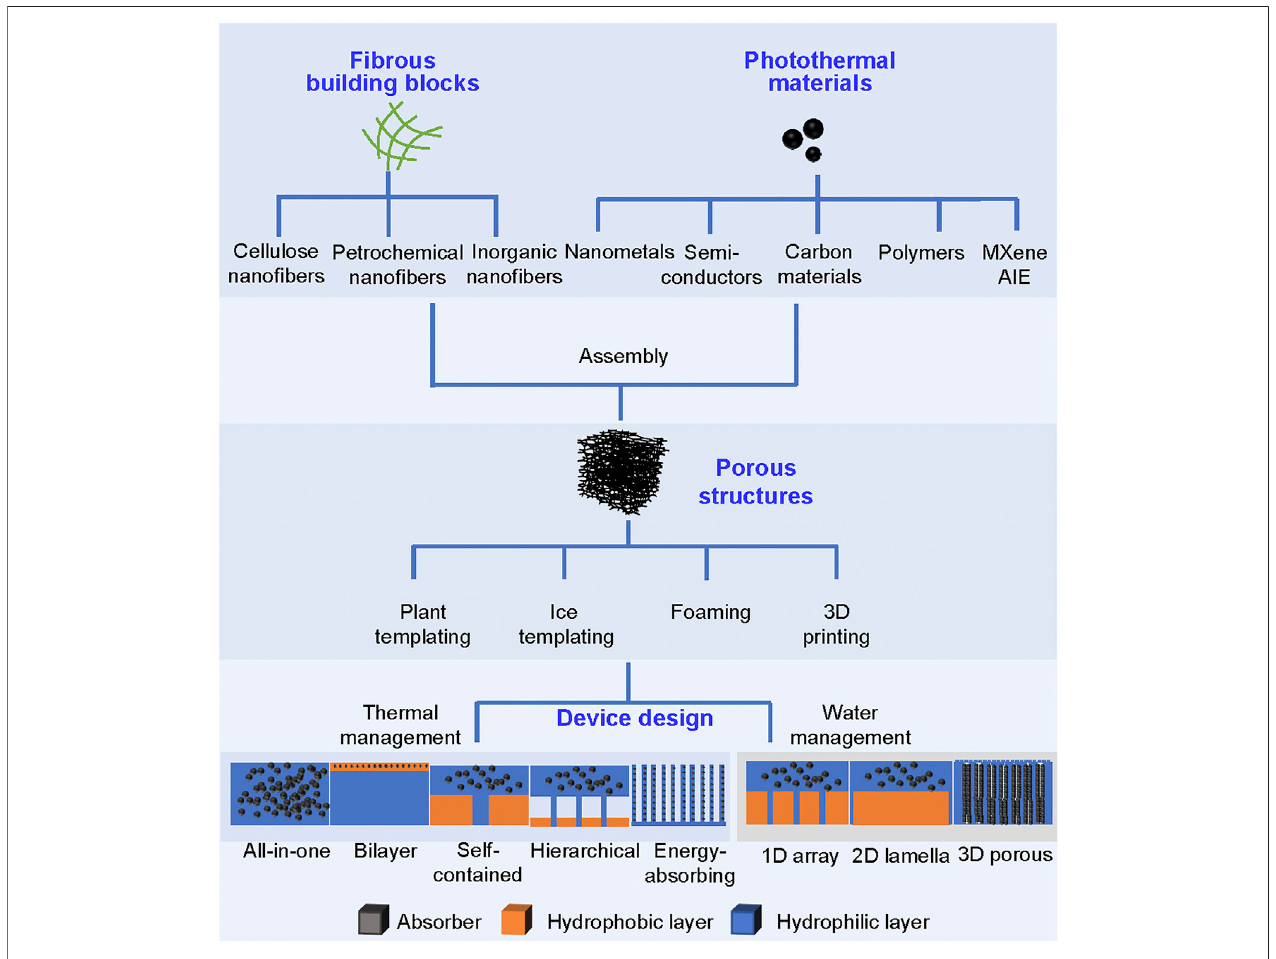
FIGURE 2 | Preparation principles of fi brous aerogels for solar vapor